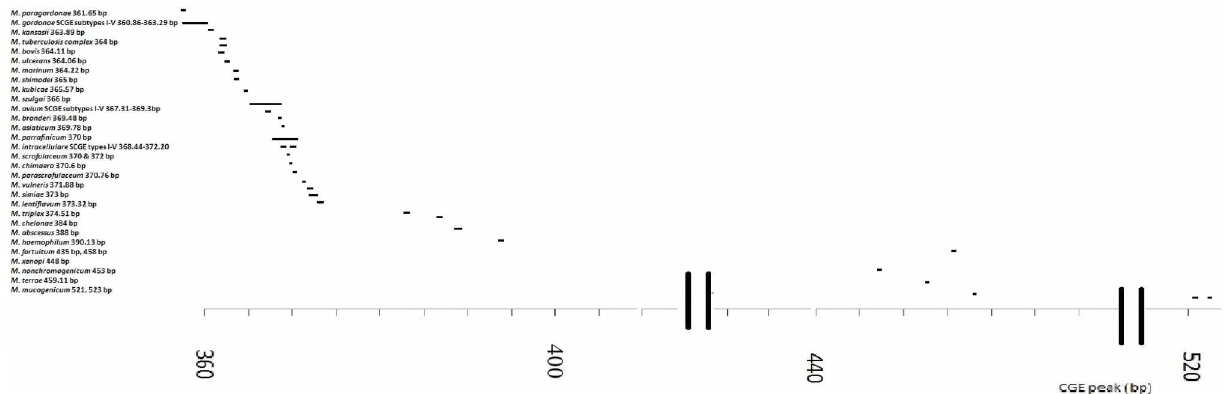
Fig 3. SCGE fragment lengths (or peaks) of 30 different Mycoabacterium species studied to